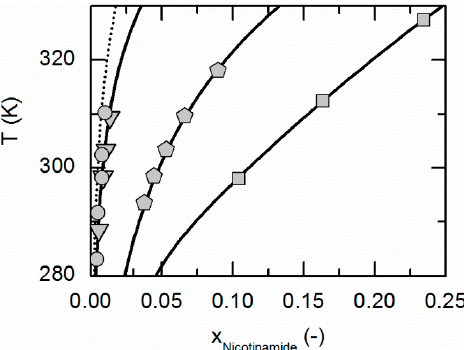
Figure 1. Solubility of nicotinamide in ethyl acetate (circles, dotted line), acetonitrile (triangles), ethanol (pentagons) and water [59] (squares). All lines correspond to the PC-SAFT correlations; symbols represent the experimental data points.